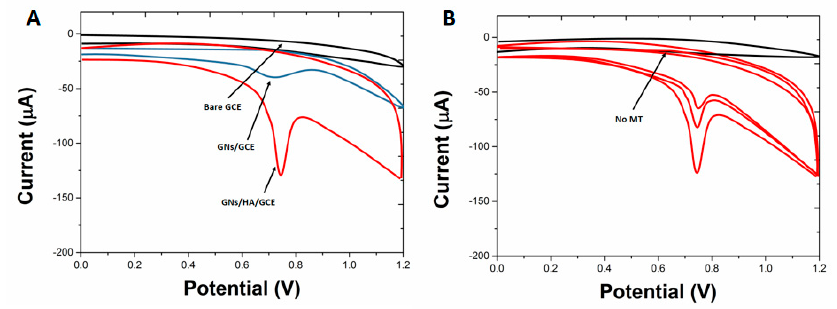
Figure 3. ( A ) CVs of 0.1 mM matrine (MT) obtained on bare GCE, GNs/GCE and GNs/HA/GCE,